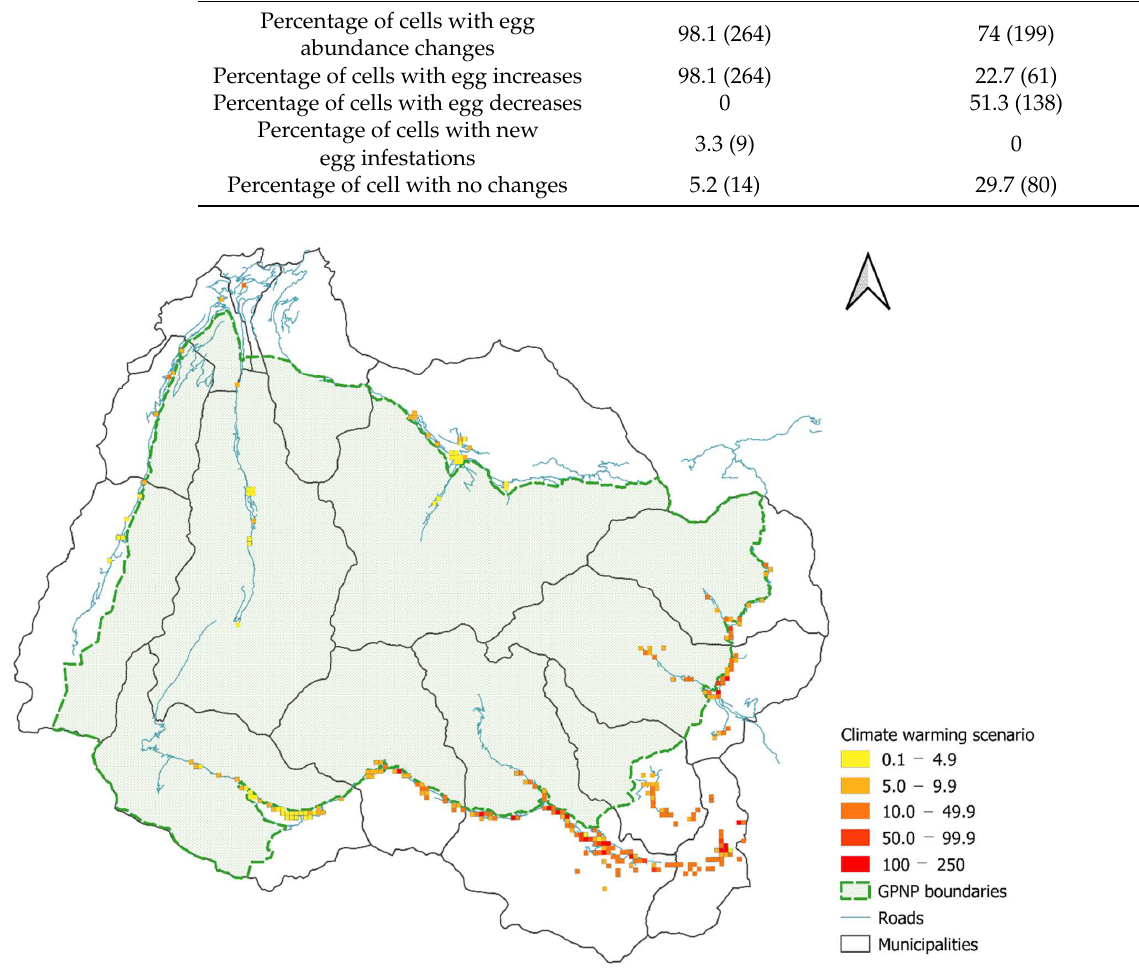
Figure 6. Expected abundance of eggs in the study area (250 m grid) in the future scenario of climate warming (increase of 1.5 °C).